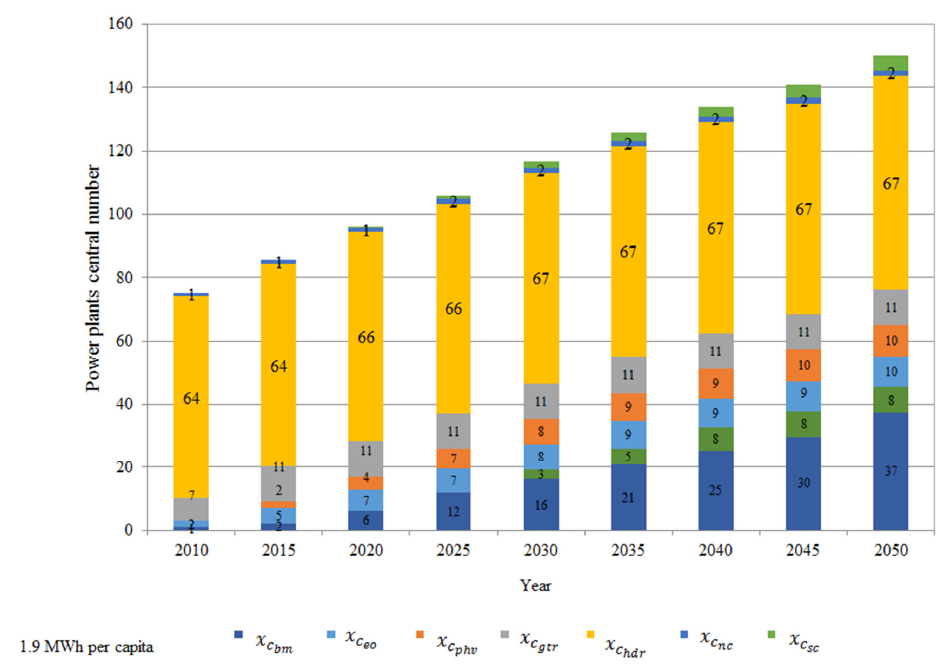
Figure 9. Optimized power plants number from clean energy resource for 1.9 MWh per capita demand with LVF model.